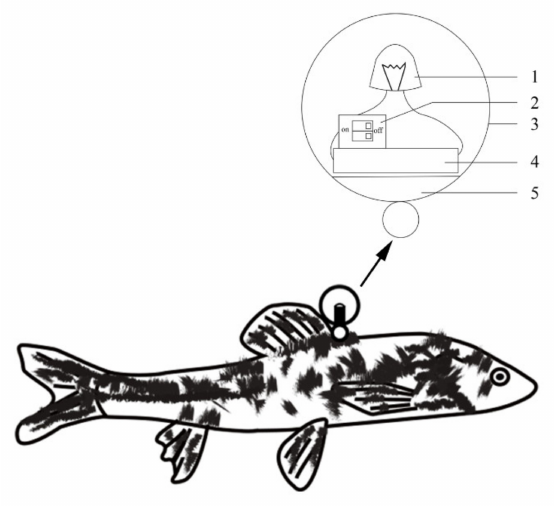
Figure 5. Composition and fixed position of the optical waterproof marker. Panels ( 1 – 5 ) represent the light source, switch, shell, power, and cover body,